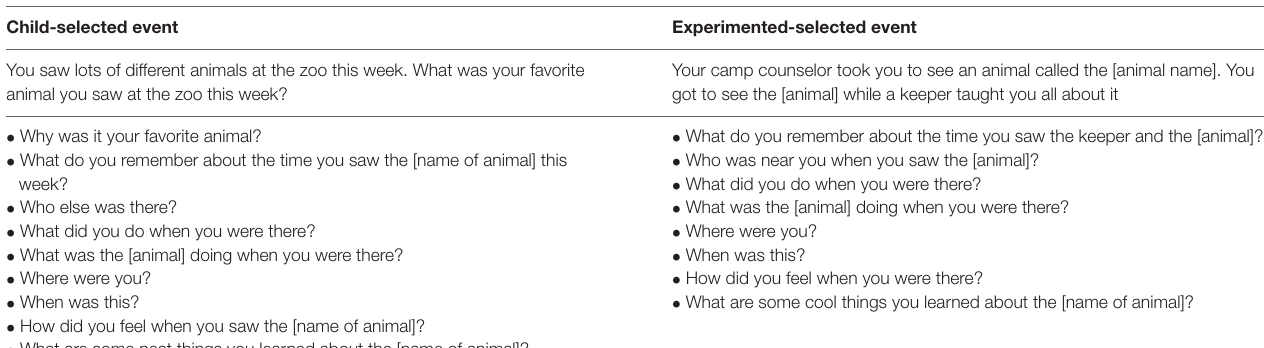
TABLE 1 | Autobiographical narratives elicitation script (interview